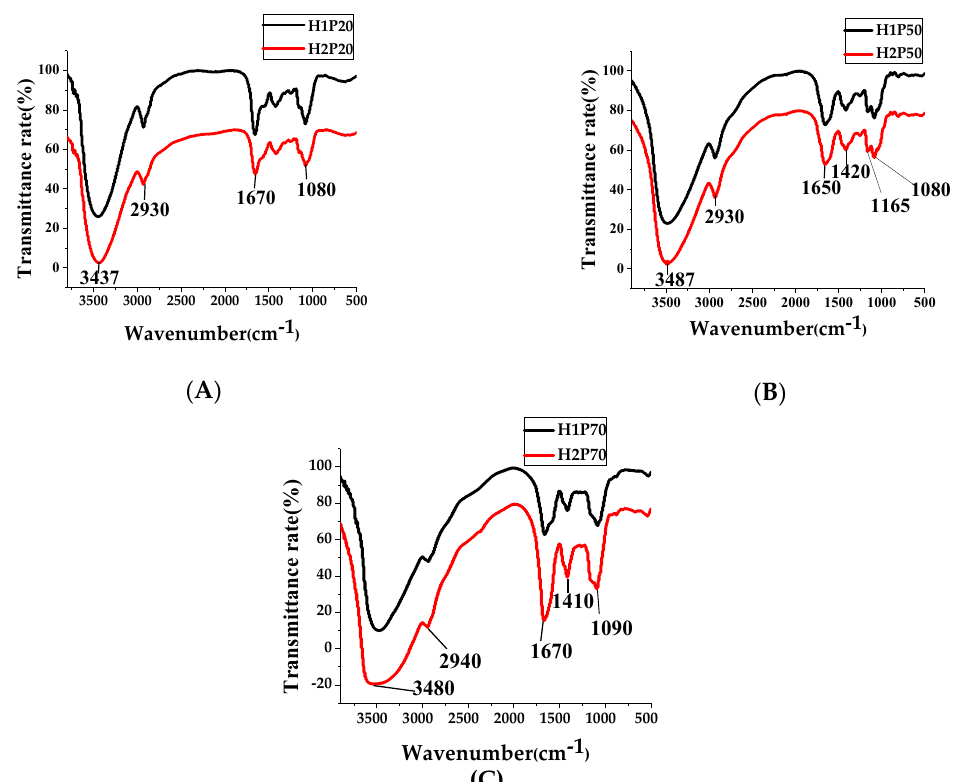
Figure 3. FT-IR spectrum of 20%, 50%, and 70% ethanol precipitated polysaccharides from fruiting bodies of H. erinaceus. ( A ) IR spectrum of 20% ethanol precipitated polysaccharides; ( B ) IR spectrum of 50% ethanol precipitated polysaccharides; ( C ) IR spectrum of 70% ethanol precipitated polysaccharides; H1P20 (H1P50, H1P70): 20% (50%, 70%) ethanol precipitated polysaccharides from the